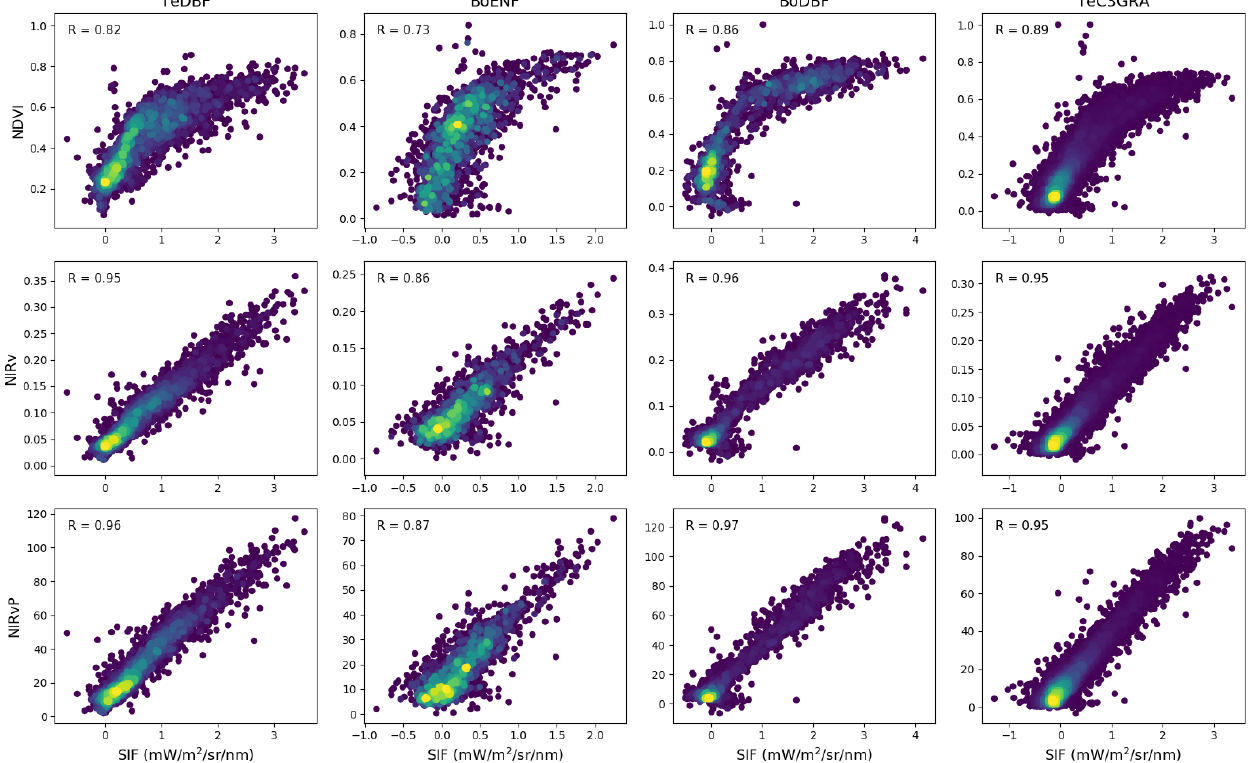
Figure 12. Comparison of weekly SIF data (743–758nm, cloud fraction < 0 . 2) with NDVI, NIRv, and NIRvP derived from TROPOSIF spectral reflectance estimates for an ensemble of 0.5 ◦ pixels representative of temperate deciduous broadleaf forest (TeDBF), boreal evergreen needleleaf forest (BoENF), boreal deciduous broadleaf forest (BoDBF), and temperate C 3 grass (TeC3GRA)